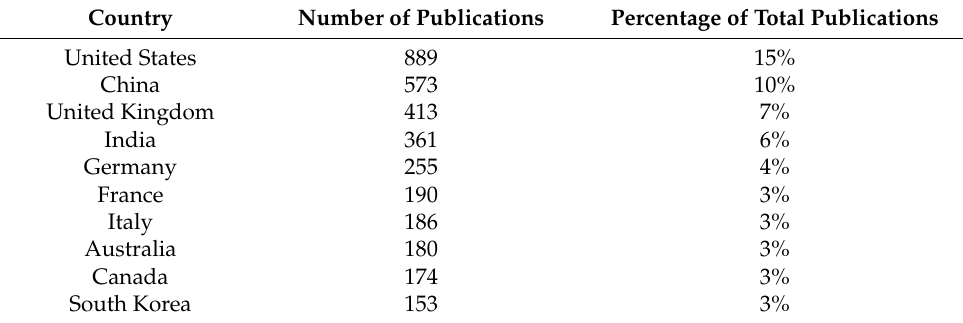
Table 9. Top 10 corresponding author’s